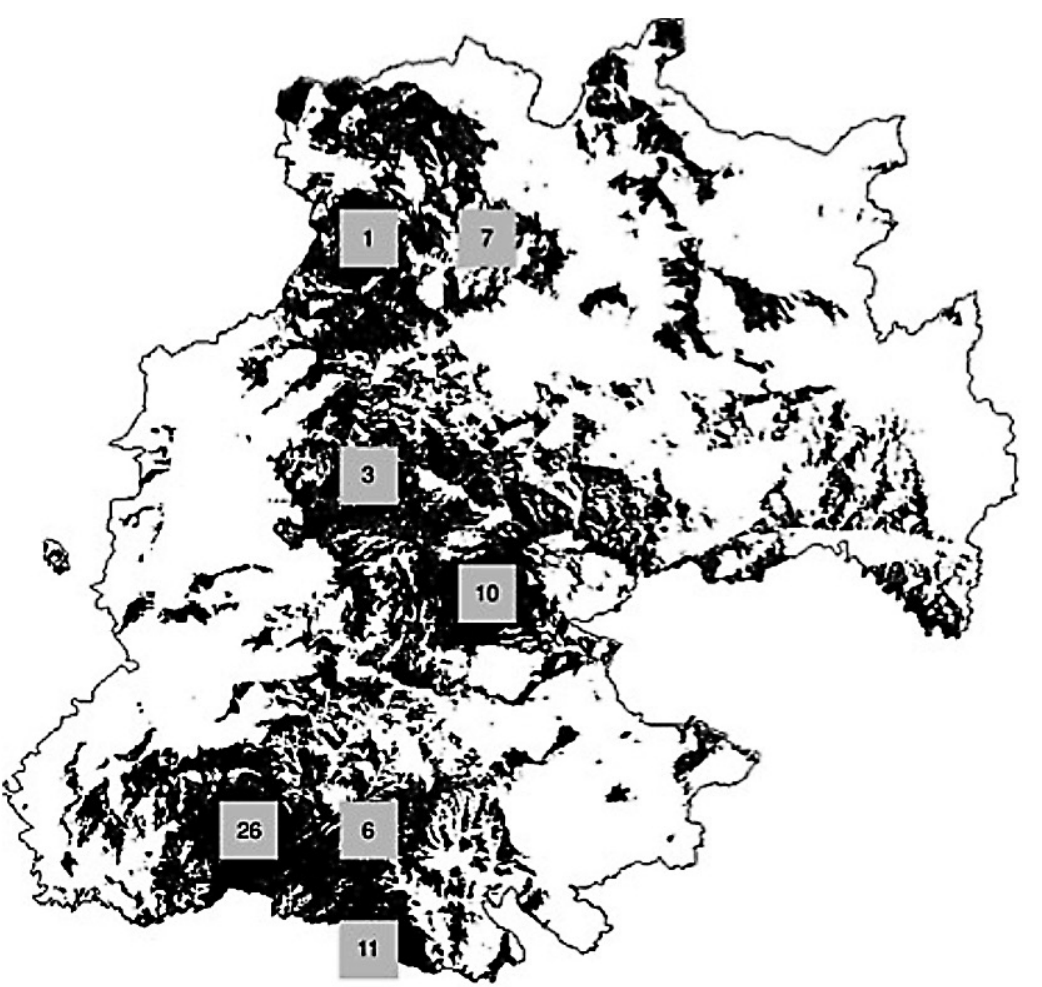
Figure 9. Cumulative intervisibility of the seven wind farms selected in the province of Enna (our GIS calculations).